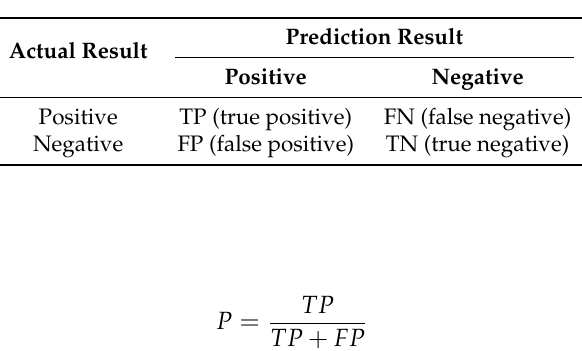
Table 2. Confusion Matrix.